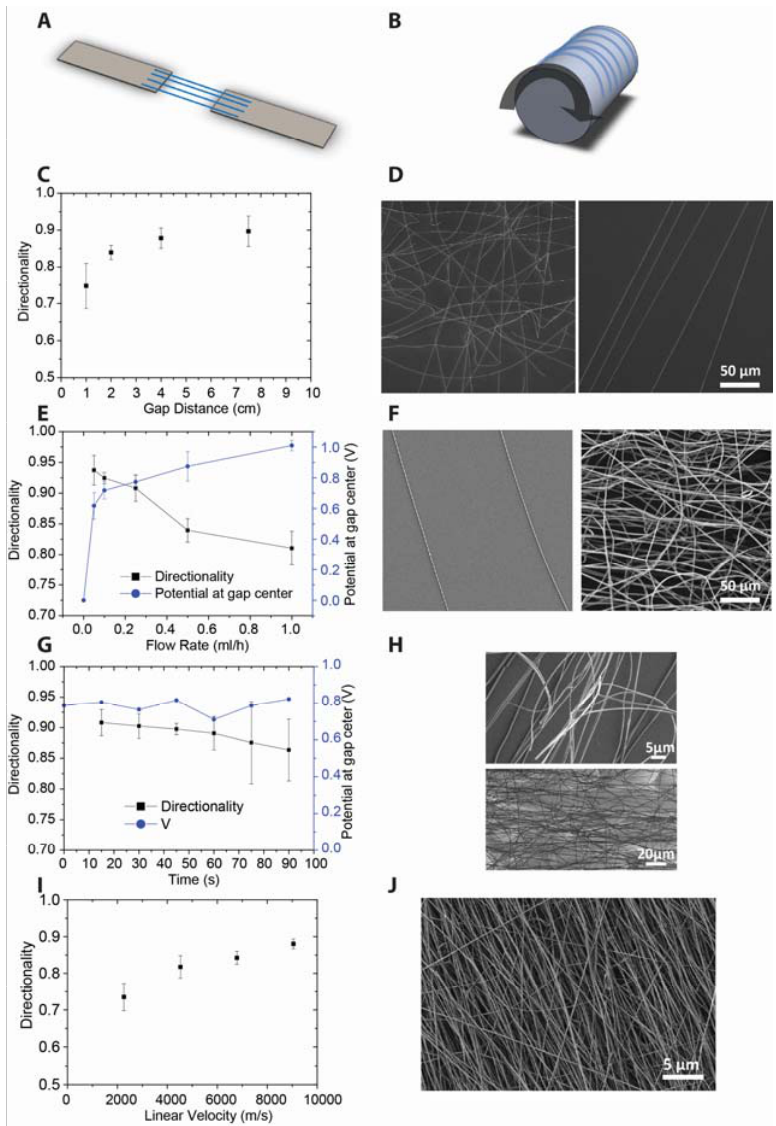
Figure 7. ( A ) Electrically ‐ driven alignment: two ground electrodes with an insulating gap; ( B ) mechanically ‐ driven alignment: rotating mandrel as the ground electrode. ( C , D ) Influence of gap distance on the degree of alignment of thermally ‐ annealed fibers after 15 s of deposition. The flow rate is 0.25 mL/h; ( C ) degree of alignment versus gap distance; ( D ) SEM pictures of the samples spun with gap distances of 1.0 and 7.5 cm. ( E , F ) Influence of the flow rate of the 3YSZ precursor solution on the degree of alignment of fibers after 15 s of deposition. Gap distance is 2.0 cm; ( E ) degree of alignment and voltage versus ground at the gap center versus flow rate; ( F ) SEM pictures of the samples spun with flow rates of 0.05 mL/h and 1 mL/h. ( G , H ). Influence of deposition time on directionality of a sample spun at 0.25 mL/h of the 3YSZ precursor solution and a gap of 2.0 cm; ( G ) degree of alignment and voltage at the gap center versus time; ( H ) SEM image of a samples spun for 90 s. ( I , J ) Mechanical alignment of nanofibers with a rotating mandrel; ( I ) degree of alignment vs linear speed of the mandrel; ( J ) Sample spun for 30 min. All samples were spun at a flow rate of 1 mL/h of 3YSZ solution and thermally treated.